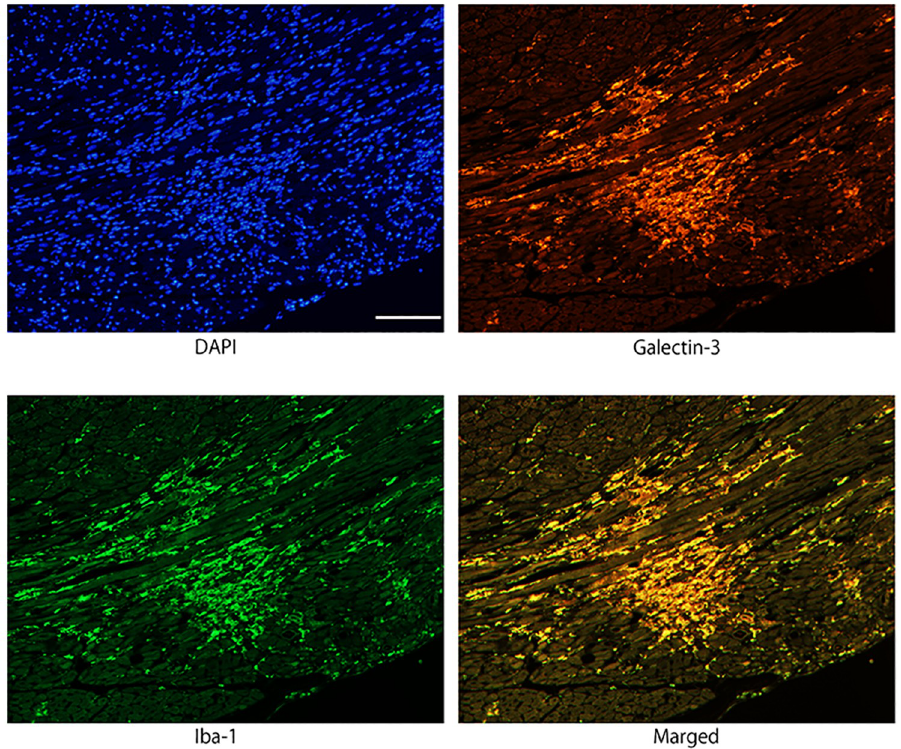
Fig 2. Immunofluorescence images confirming the co-localization of galectin-3 and Iba1 immunoreactivity in activated macrophages/histiocytes in myocarditis lesion 96 hours after EMCV inoculation. Galectin-3 and Iba1 were expressed in the same cells of merged photograph, indicating that infiltrating galectin-3 positive cells are macrophages. Scale bar = 100 μ